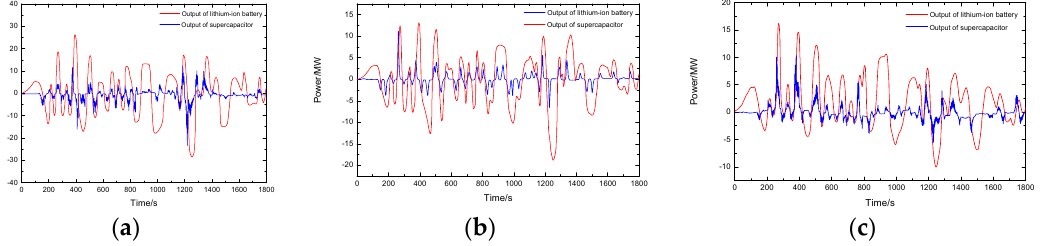
Figure 8. HESS Output Power. ( a ) NO.1 HESS; ( b ) NO.2 HESS; ( c ) NO.3 HESS.